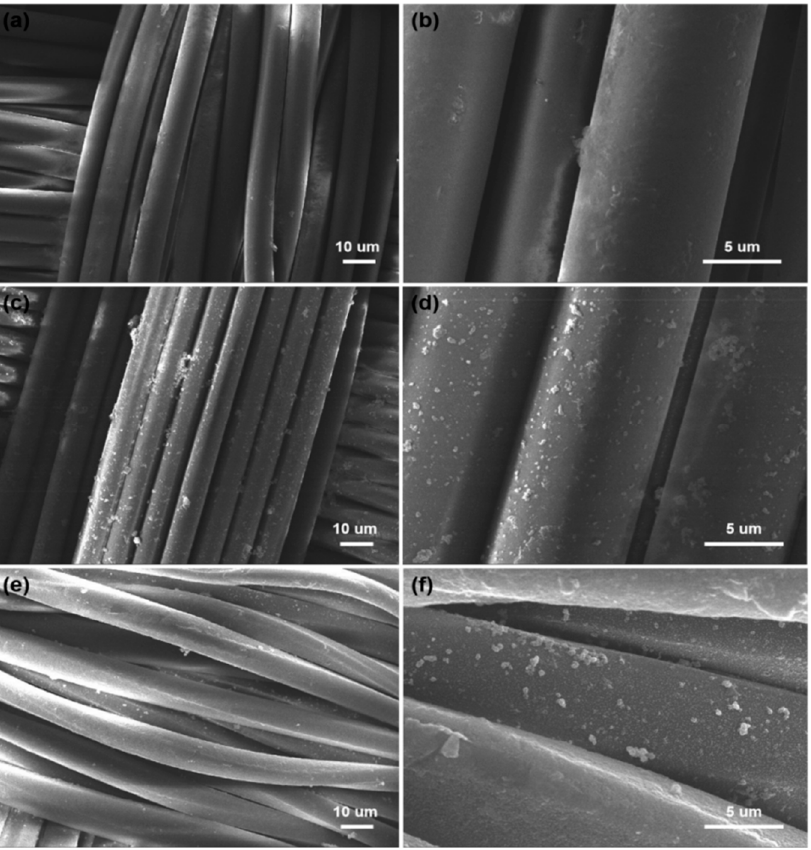
Figure 2. Scanning electron microscopy (SEM) images of ( a , b ) original PET fabrics; ( c , d ) PDA/PET fabrics and ( e , f ) Ag/PDA/PET fabrics.